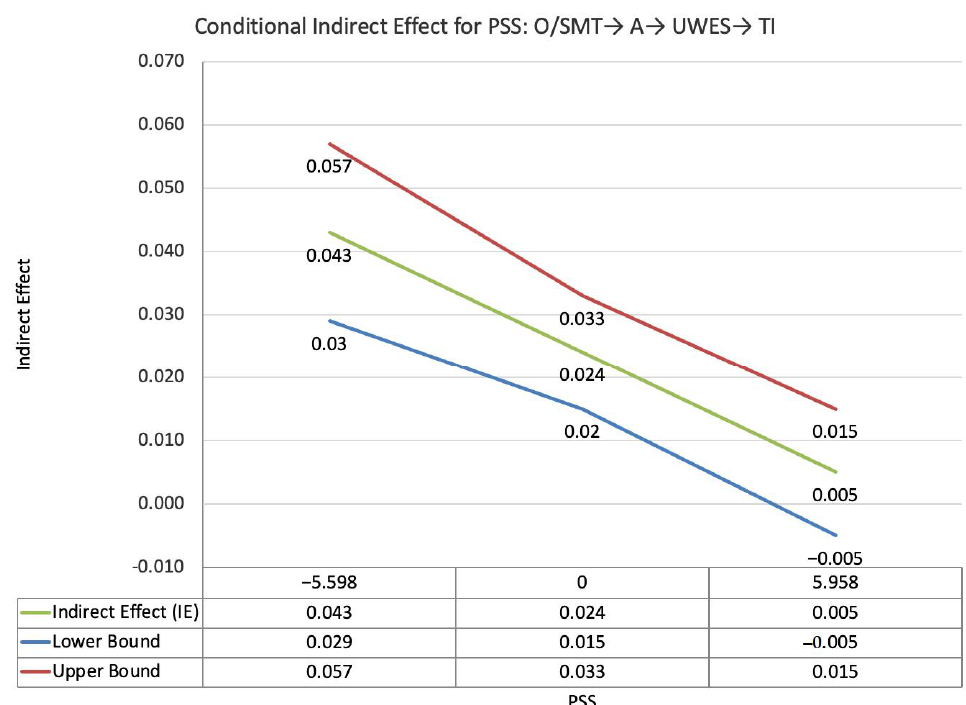
Figure 3. Conditional indirect effects of the difference between other-PMIEs compared to the control group on turnover intentions at low, average and high levels of perceived supervisor support, through autonomy satisfaction and work engagement.